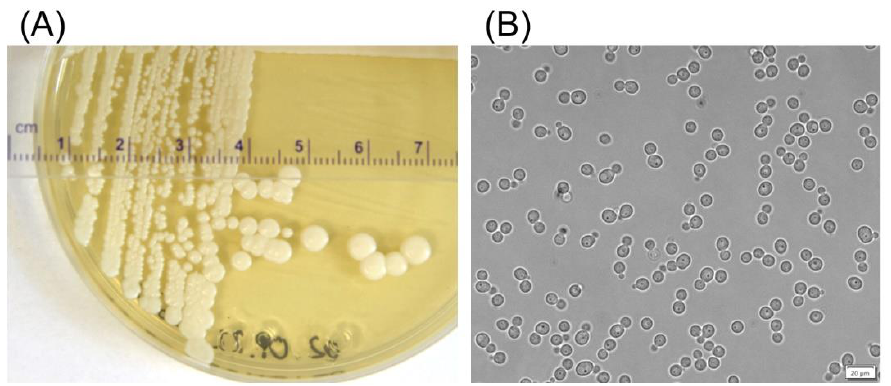
Figure 1. The yeast D50 strain grown at 20 °C on YPD agar plate for 7 days ( A ) and in liquid YPD at 150 rpm for 2 days ( B ).